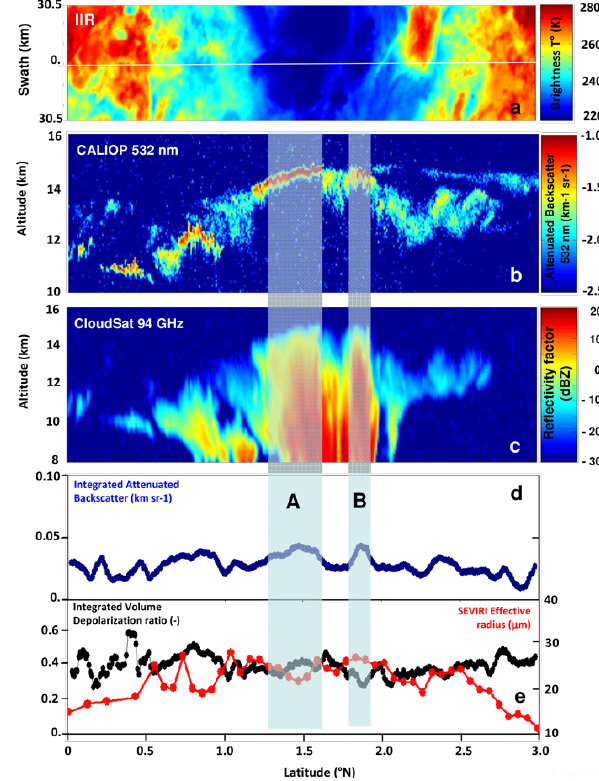
Fig. 3. MET-9/SEVIRI observations on 20 June 2008 at 15:45 UTC. (a) False colour composites from SEVIRI data and (b) brightness temperature (10.8µm channel). The pixel resolution is 3 × 3km 2 at 10.8µm wavelength and the temperature colour scale is indicated on the right side of the figure. The quasi-collocated CALIPSO track at 15:43 UTC is superimposed on the satellite images. (c–g) Re- trieved parameters from SEVIRI observations along the CALIPSO track, namely brightness temperature in the IR channel at 10.8µm, optical depth, effective radius, differences in the brightness temper- atures ( 1 BT1) between the 12.0µm and 10.8 µm channels and dif- ferences in the brightness temperatures ( 1 BT2) between the 6.2µm and 10.8µm channels. Brightness temperature from the IIR imaging radiometer is superimposed on the SEVIRI retrieved temperature in (c) .